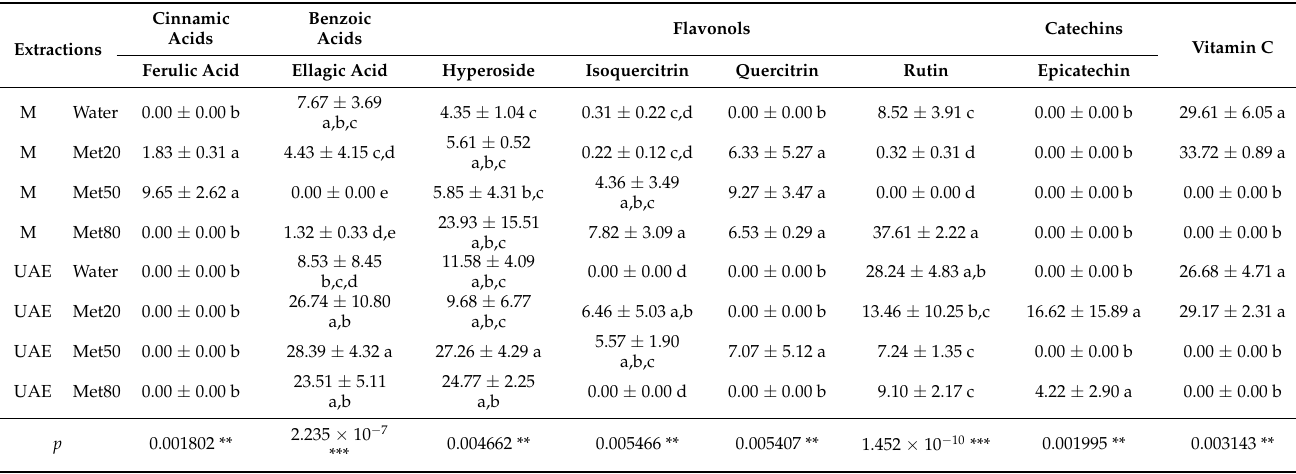
Values of mean ± standard deviation are reported. Statistical comparisons were performed using ANOVA (for ellagic acid, hyperoside, and rutin) or Kruskal–Wallis test (for the other compounds, p < 0.05 in Shapiro–Wilk’s test). Letters indicate statistical differences between the different extractions for each extracted compound. Values with the same letter are not statistically different at p < 0.05, according to Tukey’s or Dunn’s post-hoc test. ** p < 0.01; *** p < 0.001; ns = not